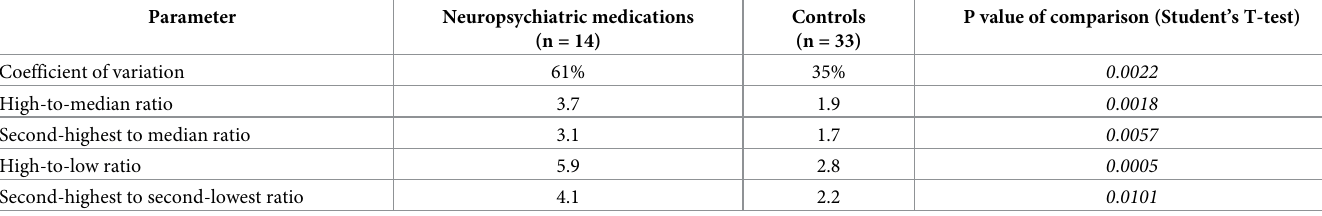
Table 3. Price dispersion